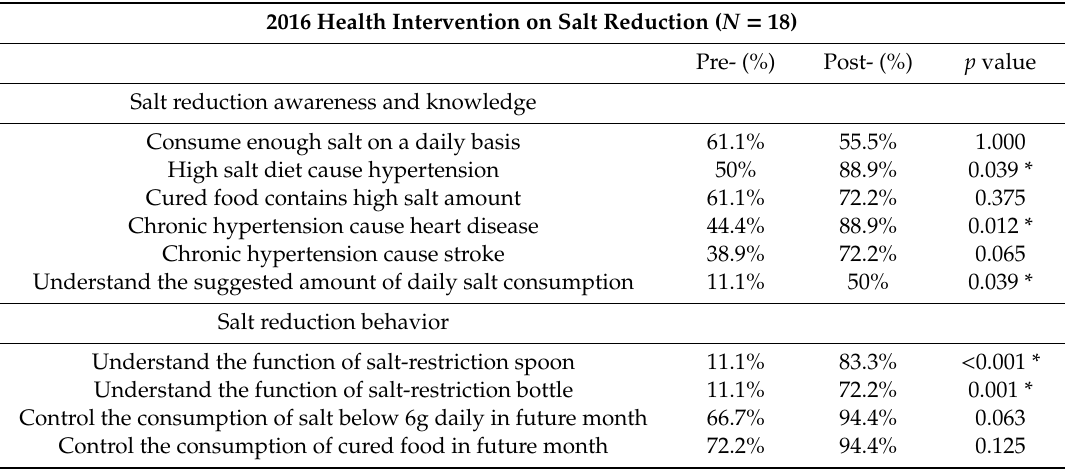
Table 5. Key findings on the e ff ectiveness of pre-and post-intervention in 2016 Salt Reduction. 2016 Health Intervention on Salt Reduction ( N = 18) Pre- (%) Post- (%) p value Salt reduction awareness and knowledge Consume enough salt on a daily basis 61.1% 55.5%